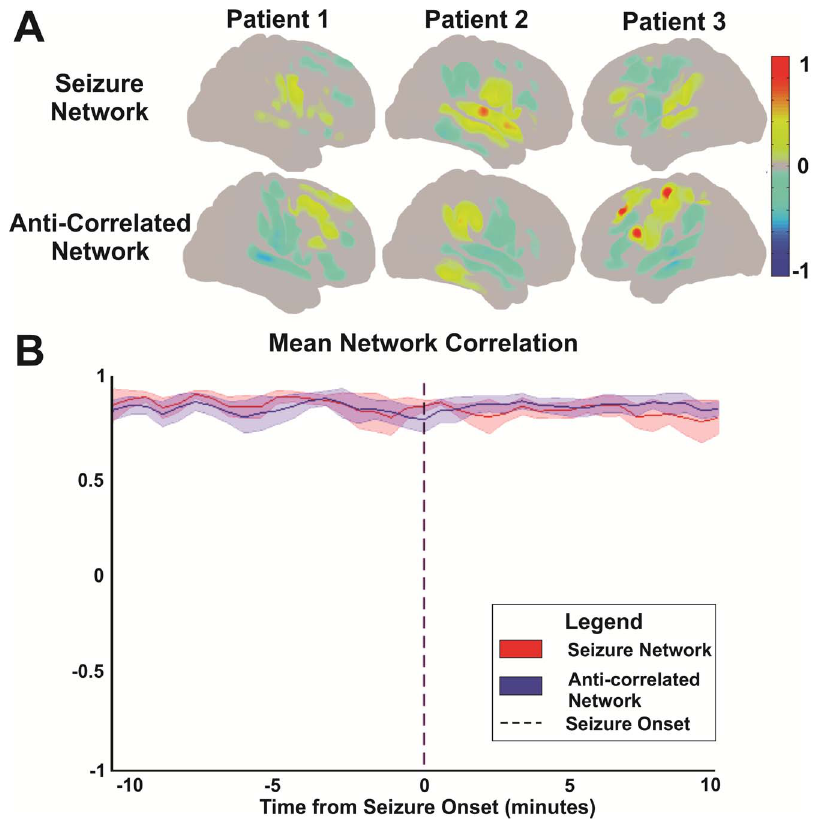
Figure 3. Network correlation structures. (A) Cortical surface topographies across patients for both the seizure and the anti-correlated networks. (B) SCP correlation topography over time. This plot demonstrates the spatial correlation between each network’s seed-based SCP correlation map computed at 30 second intervals over the course of a 20 minute ictal epoch and that computed over the same entire 20-minute ictal epoch. This plot represents a cumulative average of spatial correlation values for all patients and all seizures. Error bars represent 95% confidence intervals across the mean as determined by a one-sample t-test. Seizure onset was time-locked to minute 10 within the 20 minute epoch.